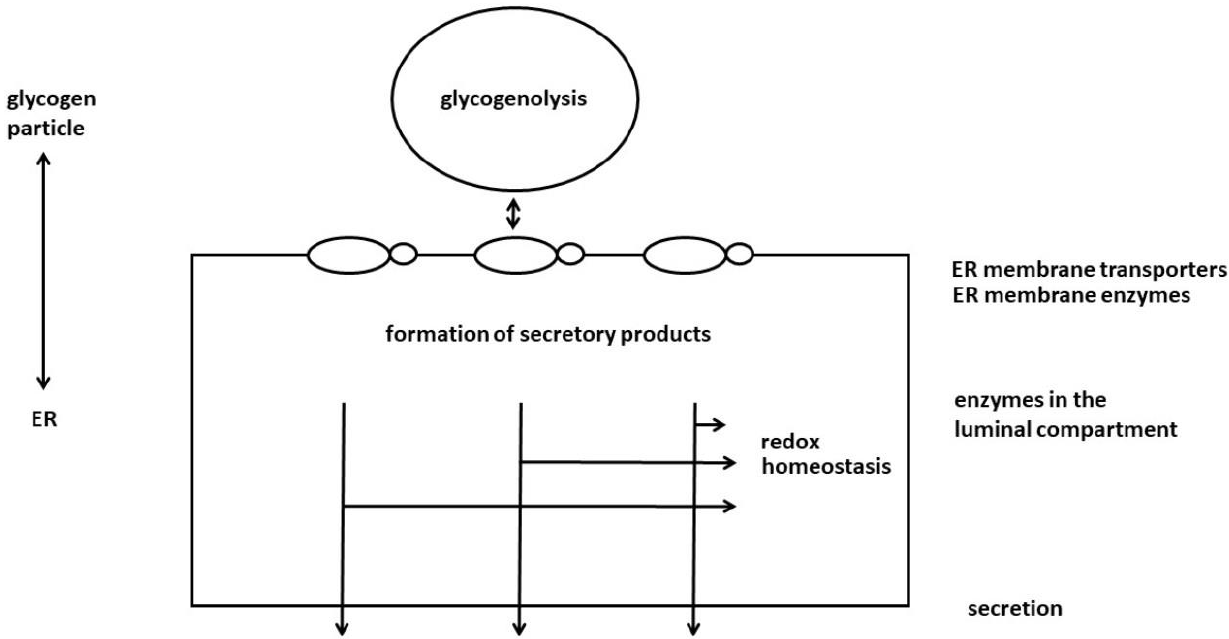
Figure 2. Glycogen particles attach to or detach from the ER membrane. When they connect, then glucose derivatives produced in glycogenolysis enter the luminal compartment of the ER via ER transporters and are further metabolized using the ER membrane enzymes linked to the transporters. In this way, glycogenolysis supplies certain biosynthetic processes in the ER with precursors. Finally, the products of biosynthetic processes are secreted. In addition, the glucose derivatives from glycogenolysis participate in shaping the redox homeostasis of the luminal compartment. Glucose derivatives can enter the pentose phosphate pathway, the operation of which is related to the formation of reduced pyridine nucleotides. The lack of drug glucuronidation affects the amount of GSH in ER. The redox regulation of glycogenolysis connected to the water-soluble antioxidants, GSH and ascorbate can also have various effects.